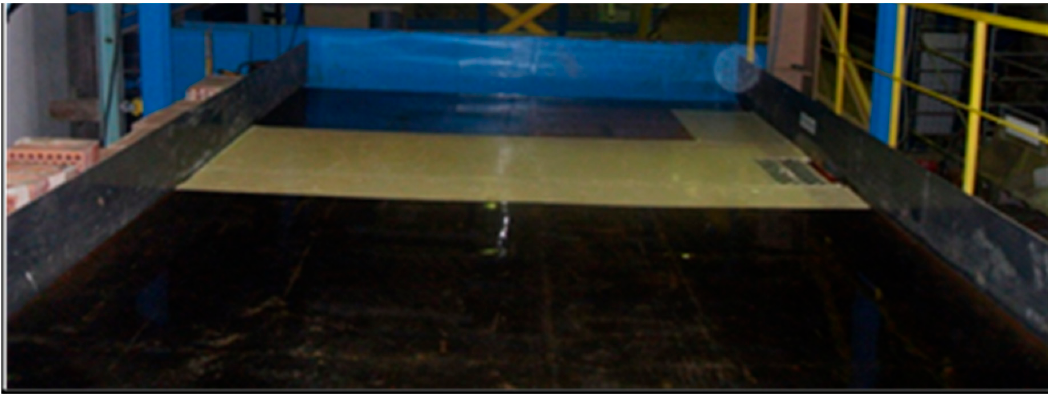
Figure 1. The platform used for the tests of grated inlets.